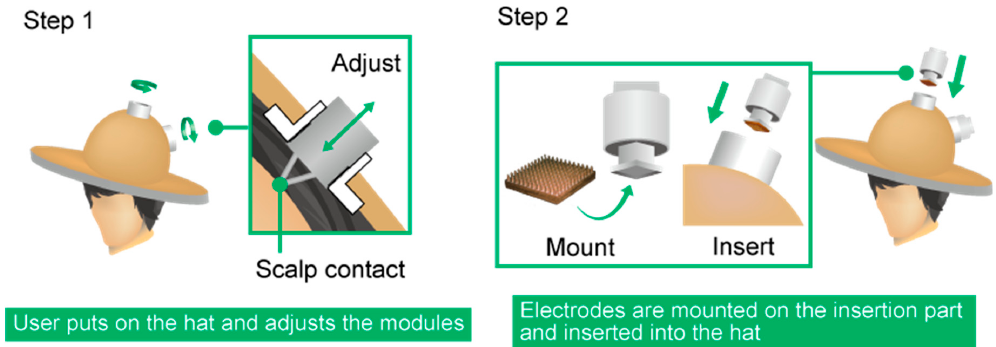
Figure 3. Use of the EEG-Hat. The preparation of the EEG-Hat for measurement involves two steps. The module can be used to adjust the hat to fit various head sizes and shapes.